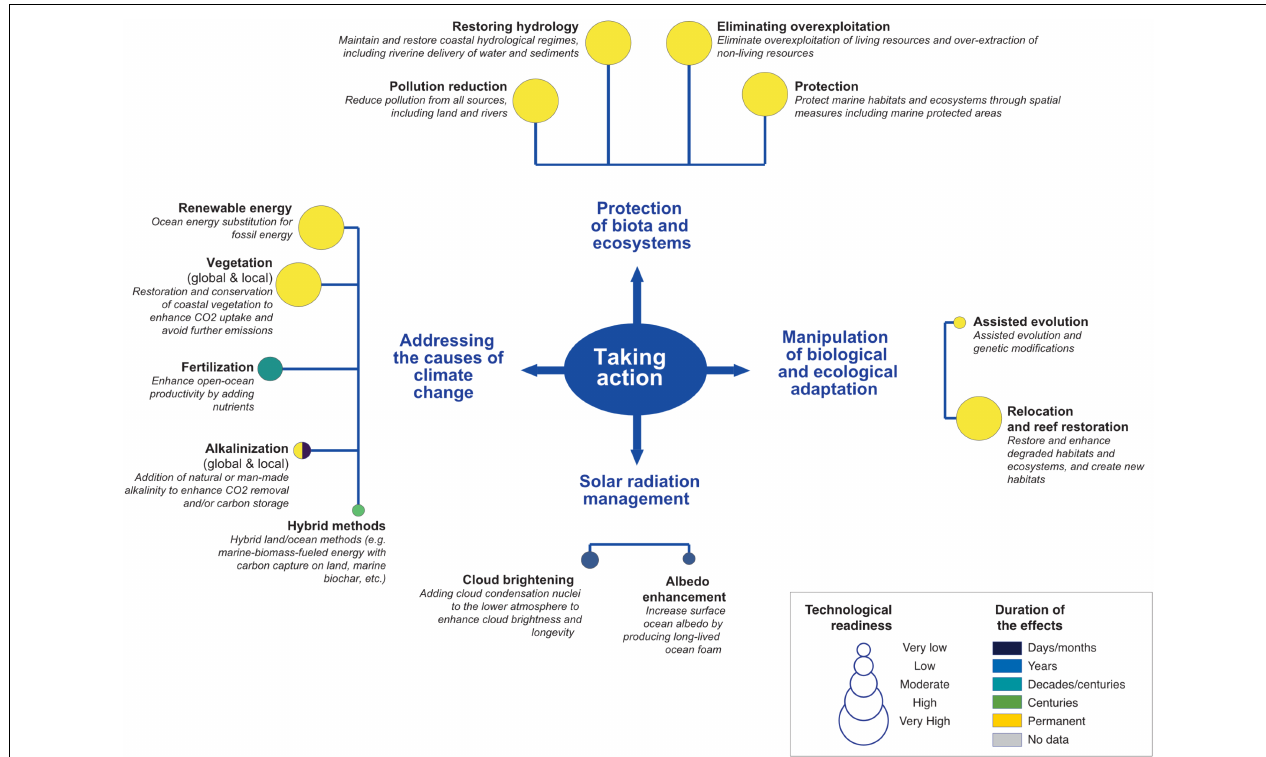
FIGURE 2 | Potential ocean solutions. Four main groups are considered: addressing the causes of climate change (i.e., reducing anthropogenic greenhouse gas emissions or increasing the long-term removal of greenhouse gases, primarily CO 2 ), solar radiation management, protection of biota and ecosystems (habitats, species, resources, etc.), and manipulation of biological and ecological